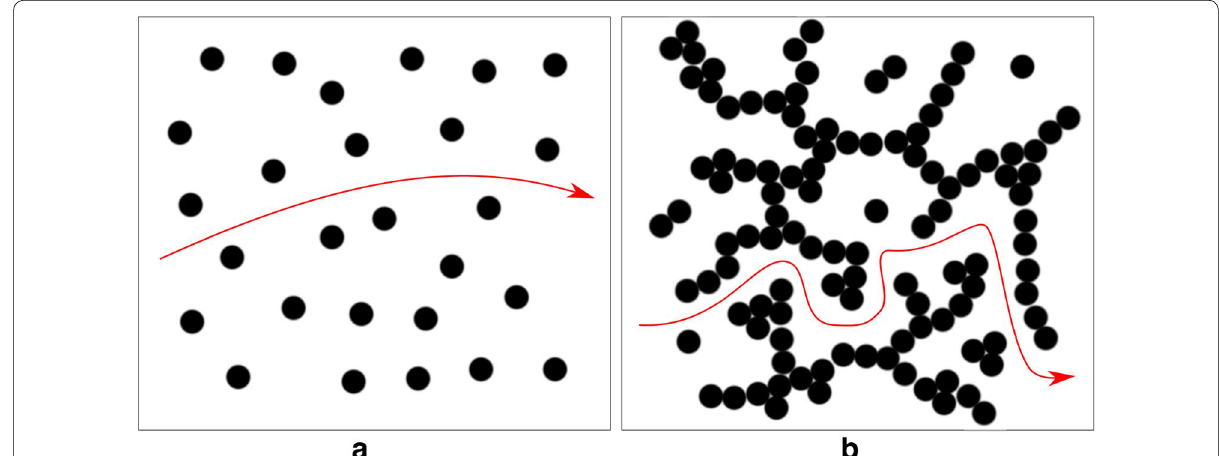
Fig. 7 The red lines in a and b clearly shows the difference in distance travelled by water molecules as they pass through the gel. a Is much shorter and represents silica sol before the addition of accelerator and the longer, b represents gelled